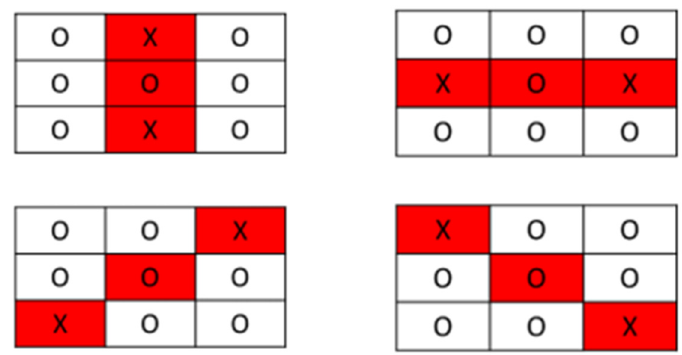
Figure 9. The refined tamper detection process.